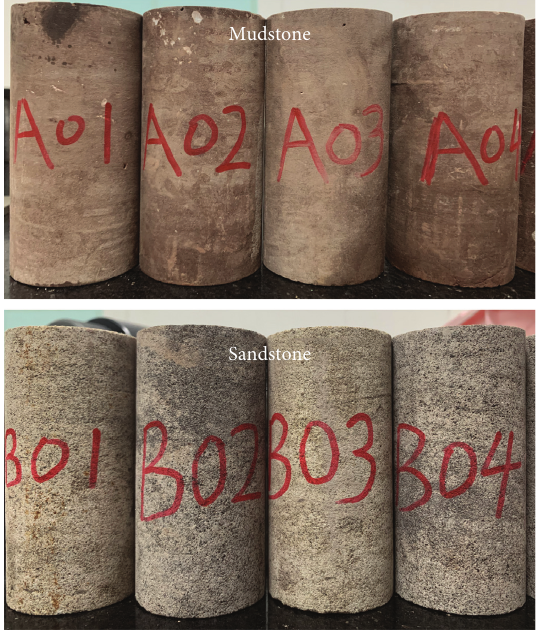
Figure 2: Conventional triaxial rock